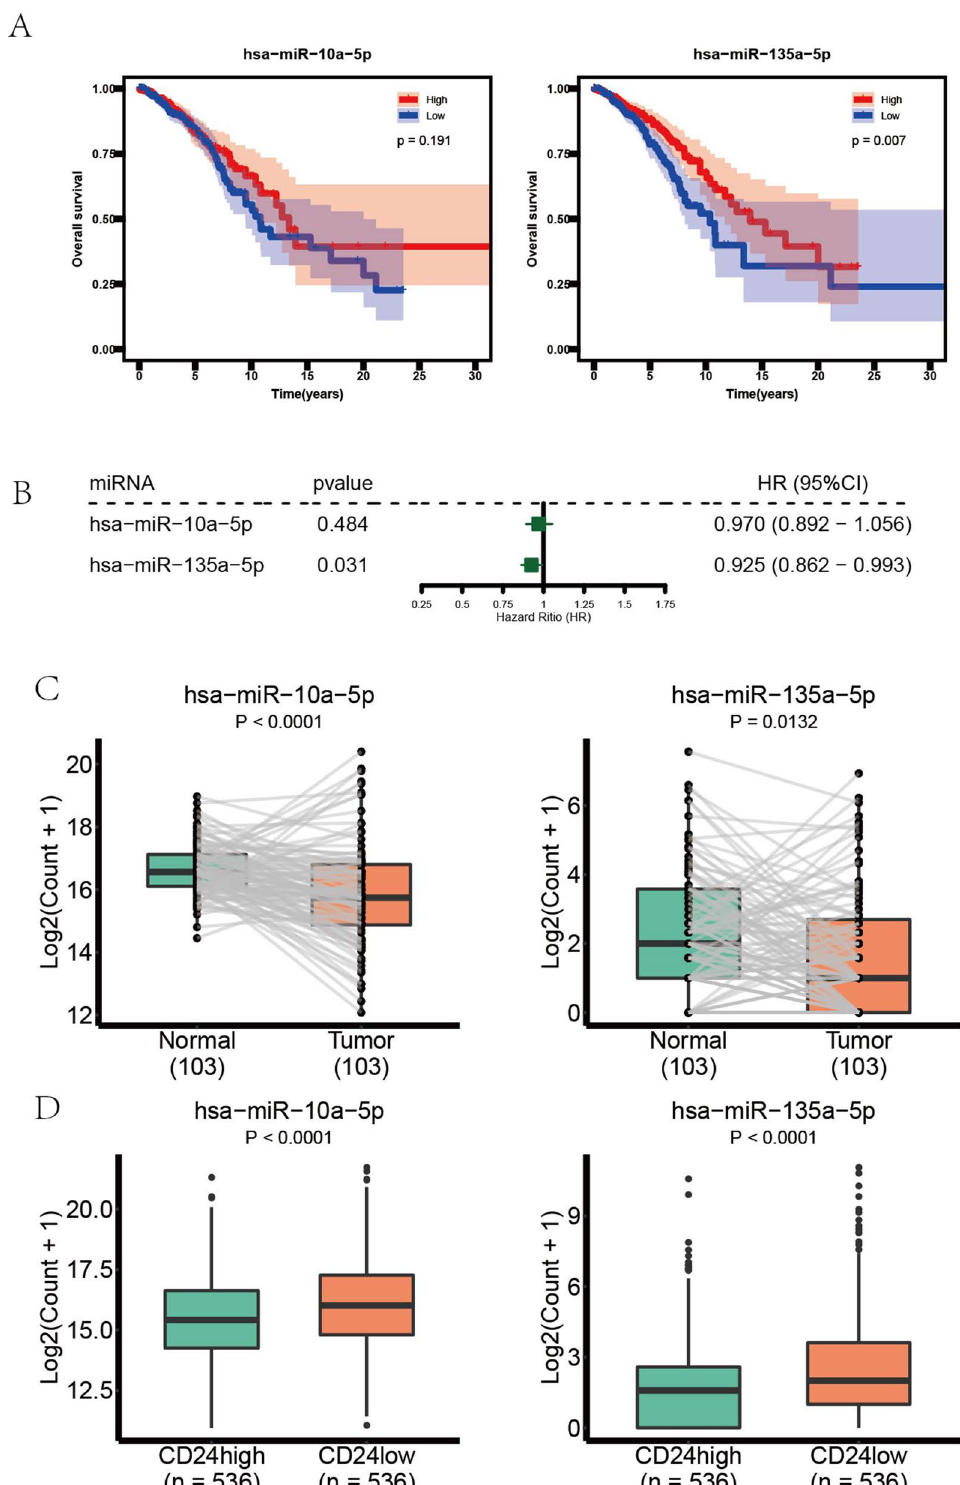
Figure 7. Comprehensive analysis of DEmiRNAs. ( A ) Kaplan-Meier curve analysis of DEmiRNAs. ( B ) Univariate Cox analysis of DEmiRNAs. ( C ) The expression levels of DEmiRNAs in tumor samples and paired adjacent normal samples. ( D ) The expression levels of DEmiRNAs in two groups: CD24high samples and CD24low